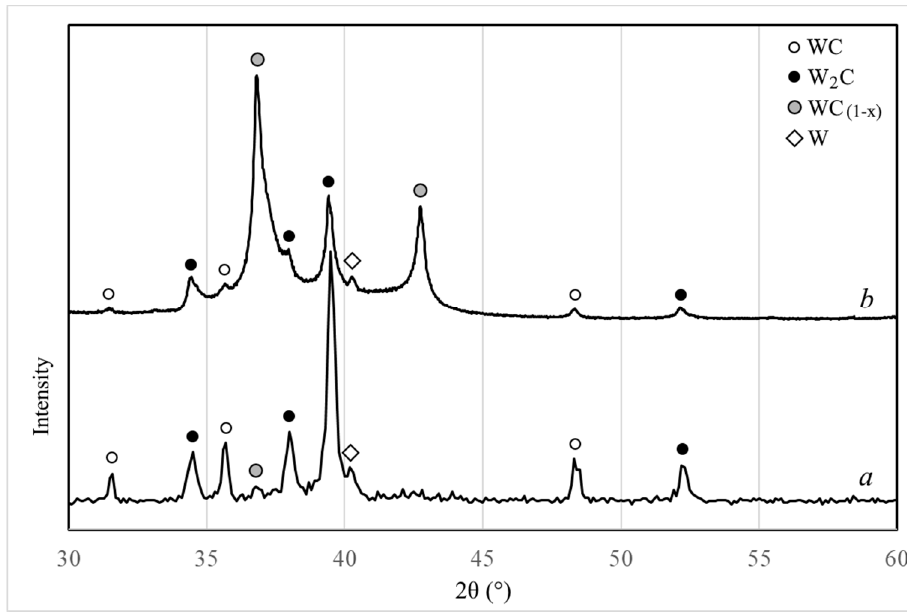
Figure 2. XRD patterns of W-C-Co ( a ) and W-C ( b ) nanopowders produced by plasma synthesis.